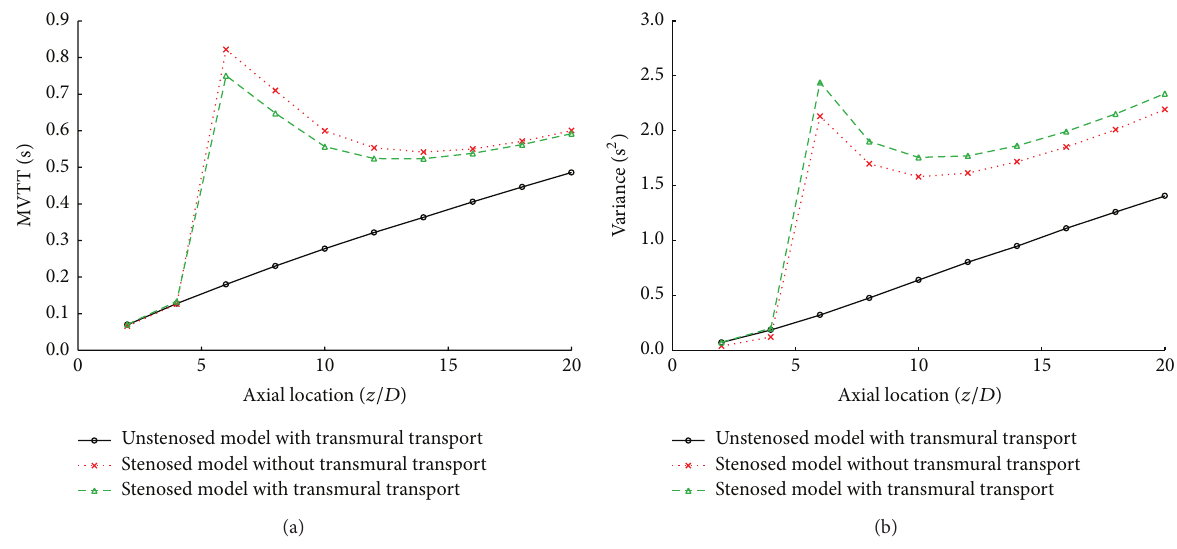
Figure 7: Comparison of the quantitative parameters of the bolus delay (MVTT) and dispersion (variance) in the stenosed artery between the model with arterial transmural transport and without. (a) The mean vascular transit time (MVTT); (b) the variance of vascular transport function